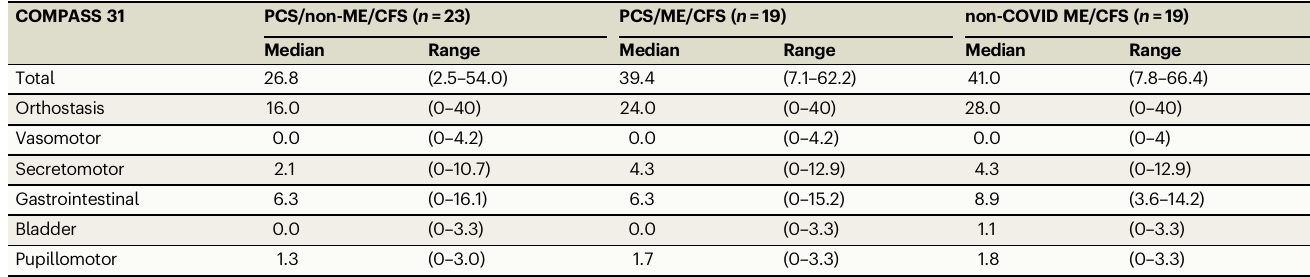
Table 3 | COMPASS 31 total score and subdomains COMPASS 31